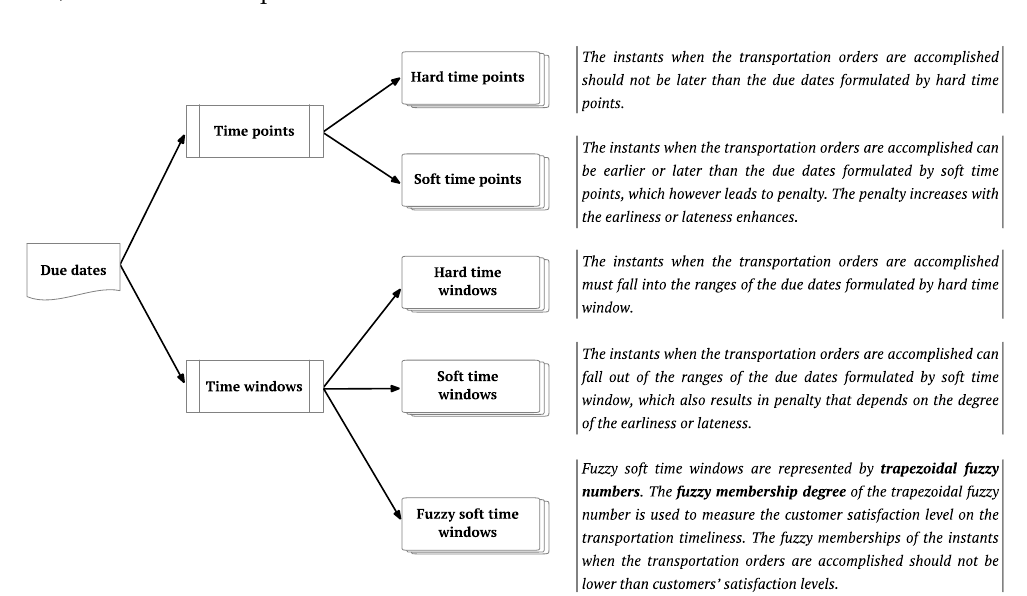
Figure 3. Formulations of the due dates to improve timeliness.